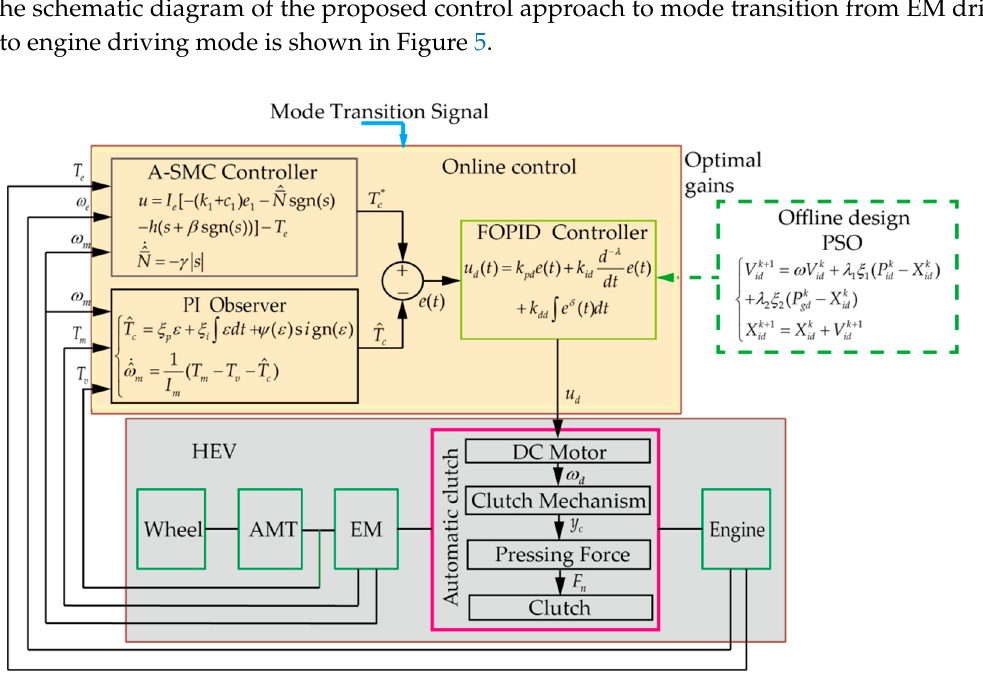
Figure 5. Schematic diagram of the proposed control method.